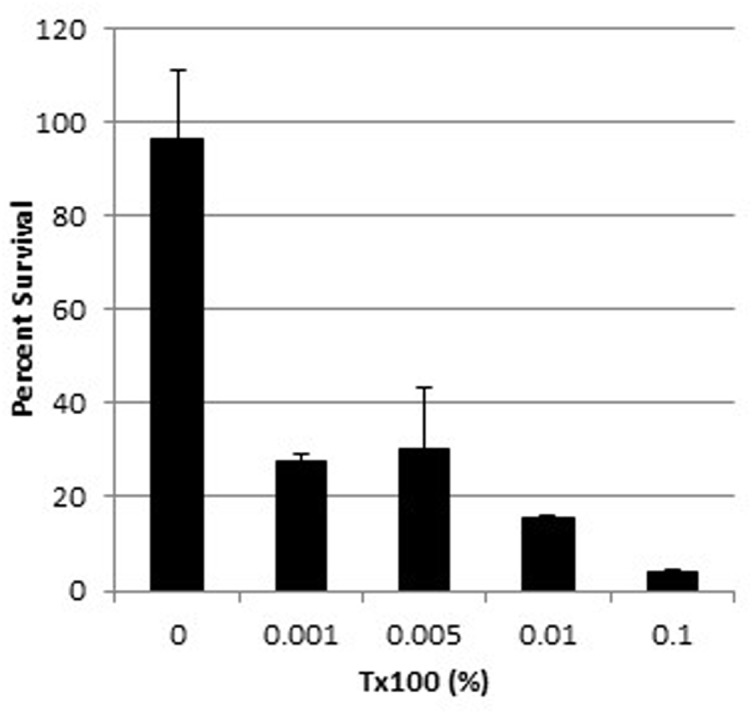
Survival of WBG 8287 exposed to 5 μg ml-1 mel12-26 with increasing concentrations of Triton X-100. Data represent the mean of three tests and error bars show standard deviation.